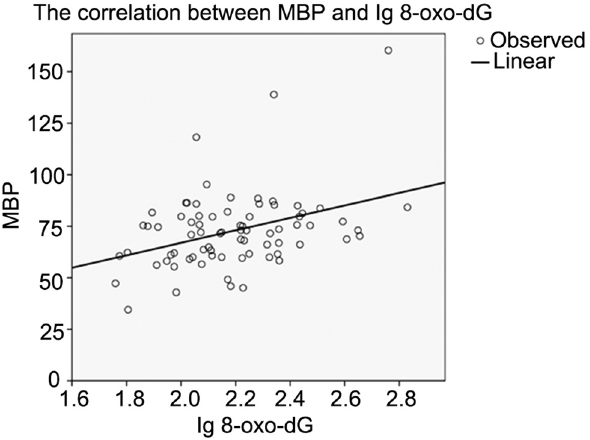
Figure 1: The correlation between MBP and Ig 8 - oxo - dG.